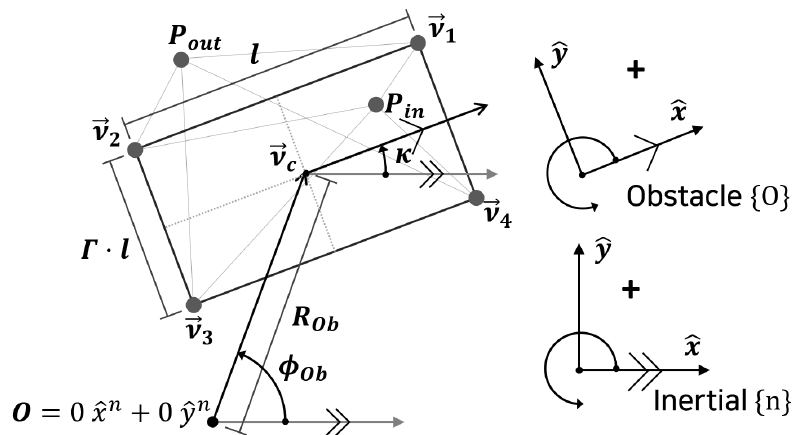
Figure 3. Geometry of rectangular